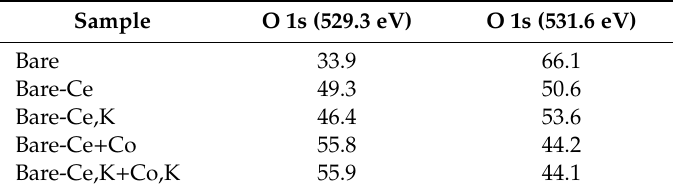
Table 5. Deconvolution of O 1s binding energies to spin-orbit components